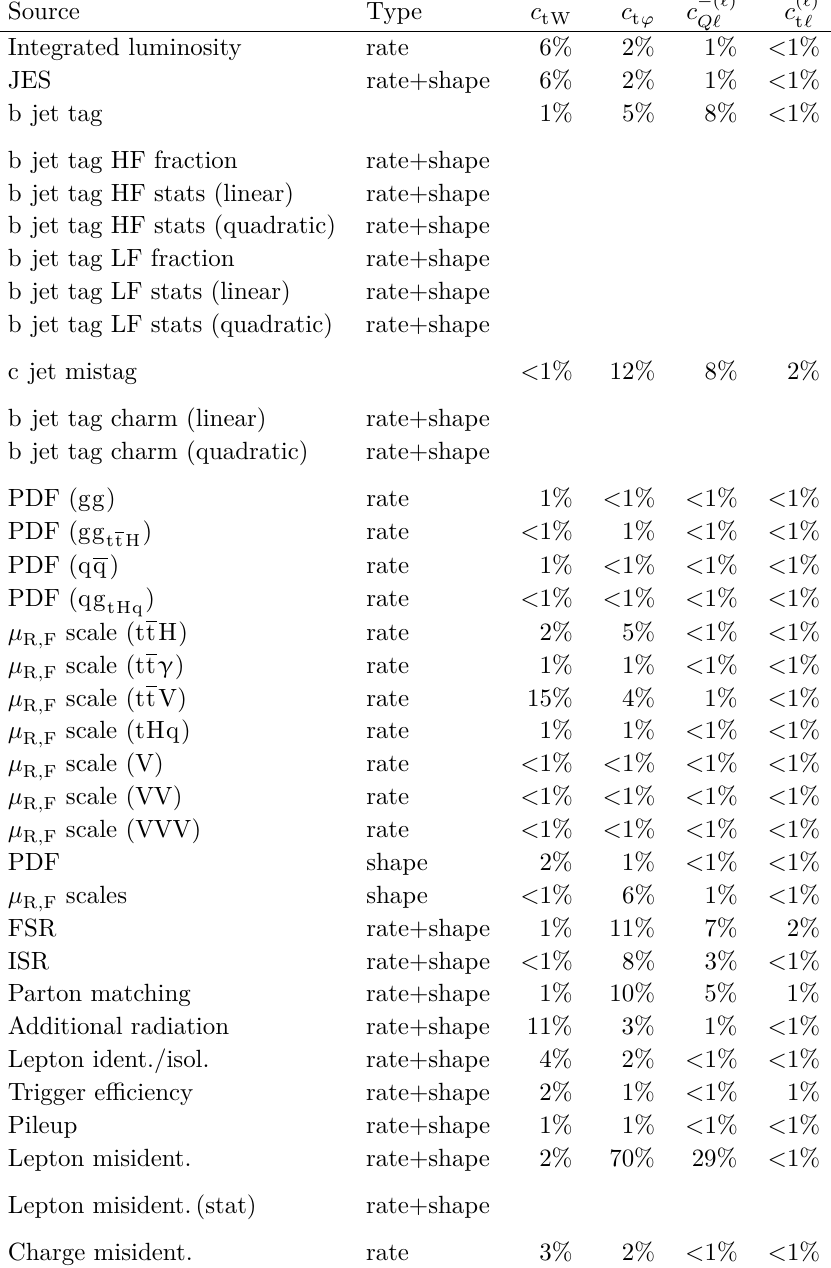
Table 4 . Summary for the systematic uncertainties. Here “shape” means that the systematic uncertainty causes a change in the relative expected yield of the jet and/or b jet bins. Except where noted, each row in this table will be treated as a single, independent NP. Impacts of various systematic variations on a subset of WCs are also quoted. Percentages represent the change in a WC divided by the symmetrized 2 σ confidence interval. A value of 100% indicates the particular systematic variation adds an uncertainty equal to the WC interval. The percentages for the b and c jet tags are the sum of all their respective